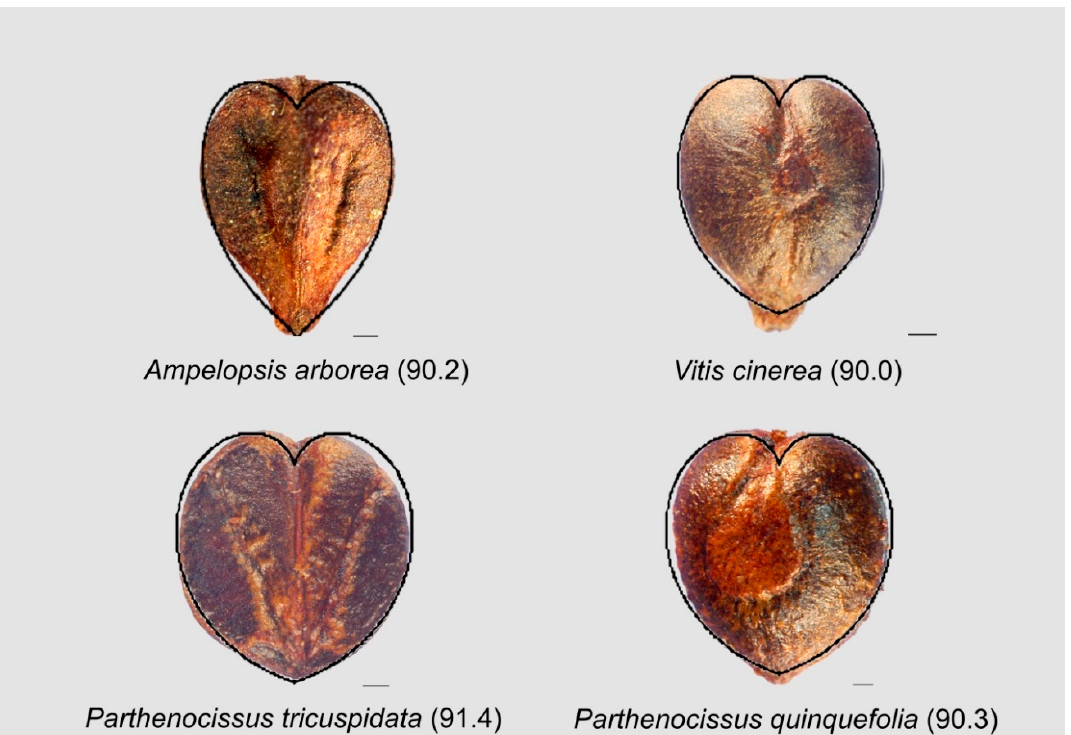
Figure 17. Heart-shaped curves in the Vitales. The values indicated correspond to J index in the images shown and do not represent mean values for each particular species. Bar equals 0.5 mm.